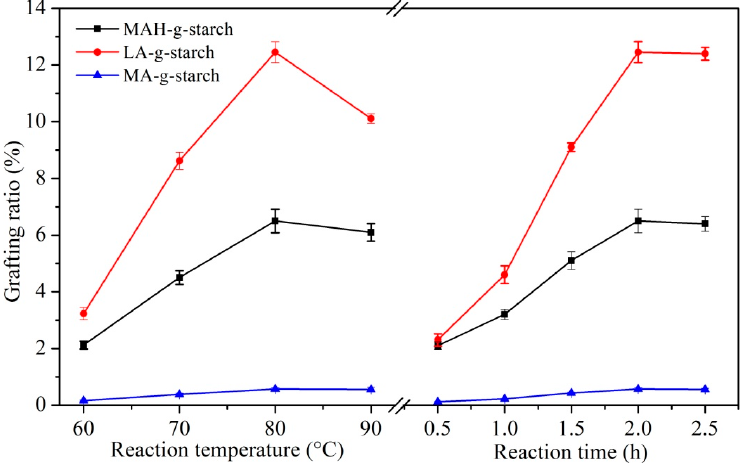
Figure 4. Effect of reaction temperature and reaction time on grafting rate of grafted